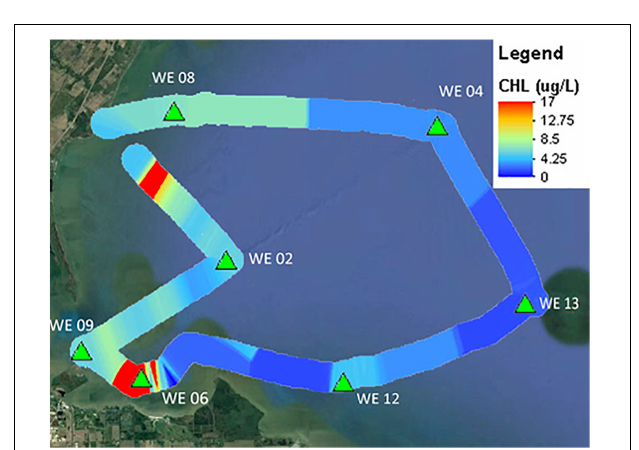
FIGURE 2 | Chlorophyll-a contour plot generated by the PhycoProbe TM during an underway mapping survey in western Lake Erie during the ACT performance verification of in situ fluorometers for detecting HABs. Color bar indicates chlorophyll-a concentration ranging from high (red) to low (blue). Modified from ACT Verification Report